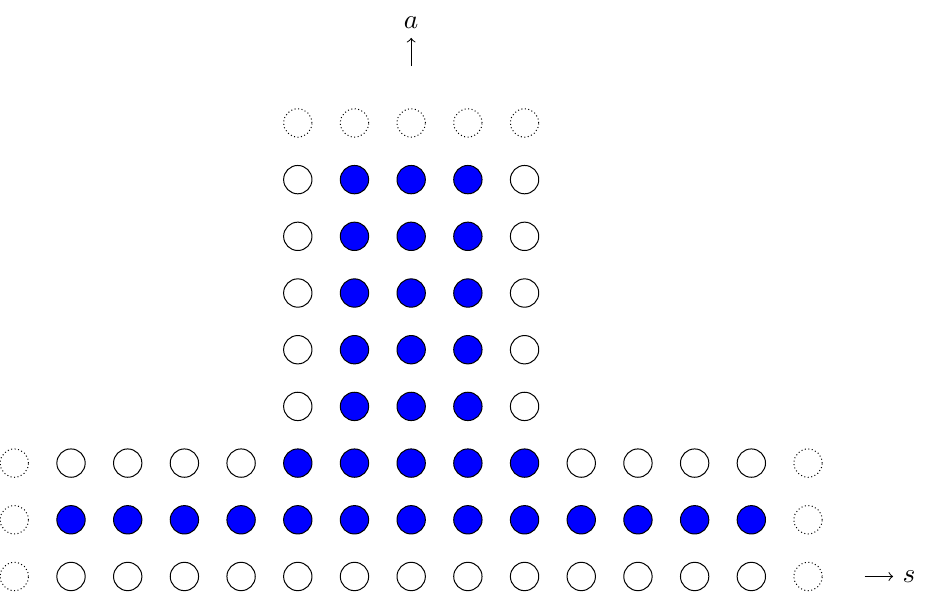
Figure 6. There exists one Y-function Y a,s ( u ) for each ( a, s ) ∈ M (defined in eq. (B.1) and shown in blue) and one T-function T a,s for each ( a, s ) ∈ ˆ M (defined in eq. (C.1) and shown as union of blue and